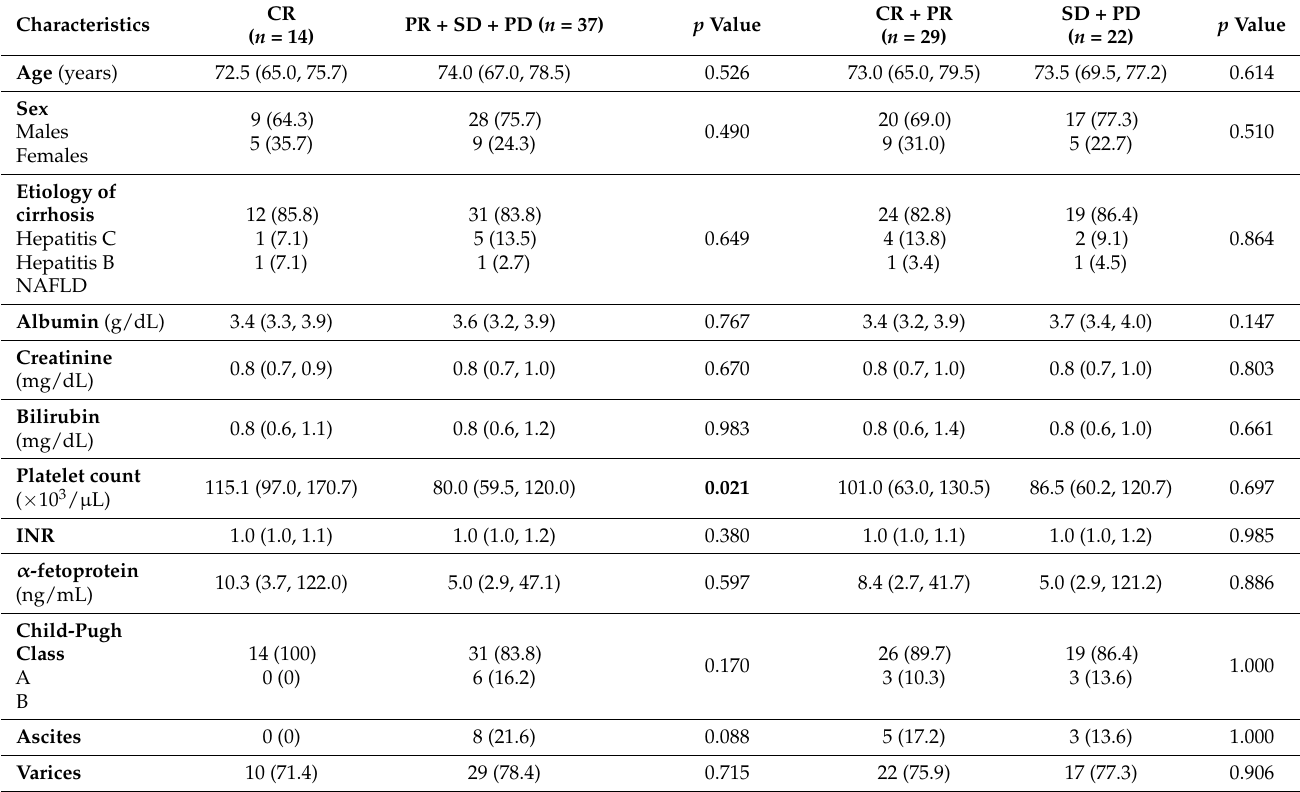
Table 1. Differences in clinical characteristics according to the post-treatment